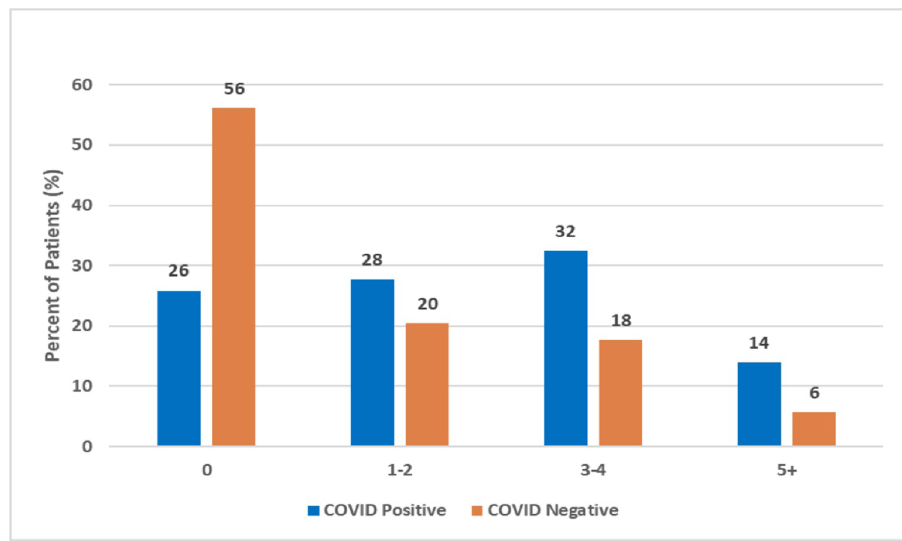
Fig 2. Number of symptoms with Covid positive and negative